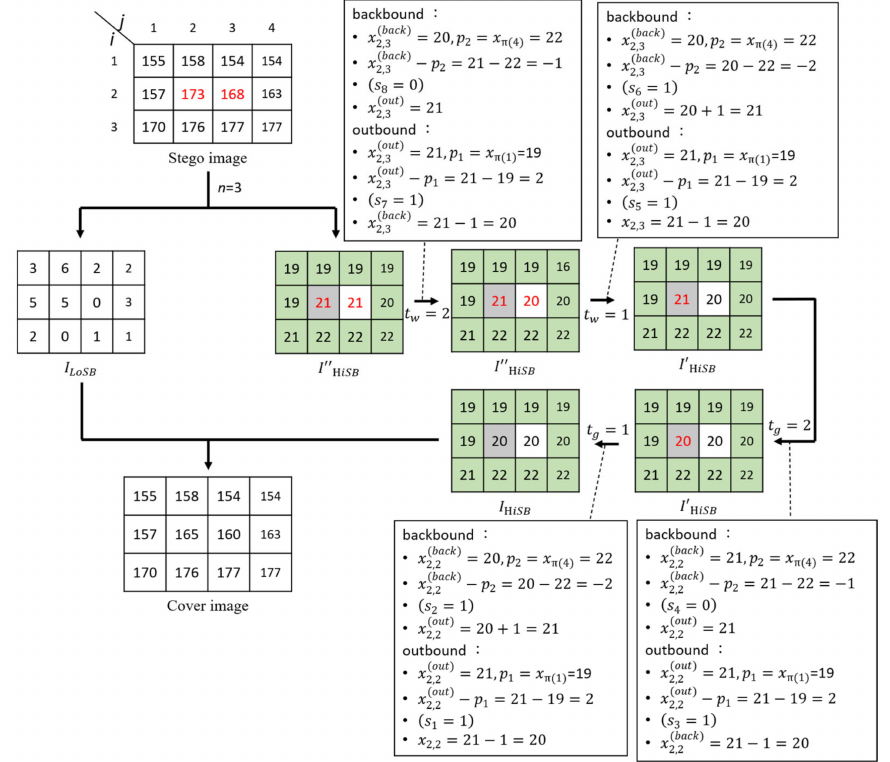
Figure 7. Example illustration of message extraction and pixel recovery.